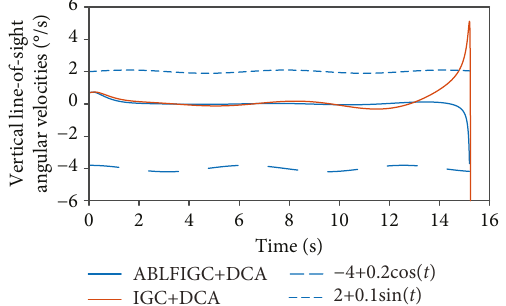
Figure 17: Curves of equivalent rudder de fl ection angle δ ABLFIGC+DCA refers to a combination of the proposed asymmetric barrier Lyapunov function-based IGC algorithm and the dynamic control allocation algorithm; IGC+DCA refers to a combination of the IGC algorithm subject to the traditional dynamic surface sliding-mode control law and the dynamic control allocation algorithm.